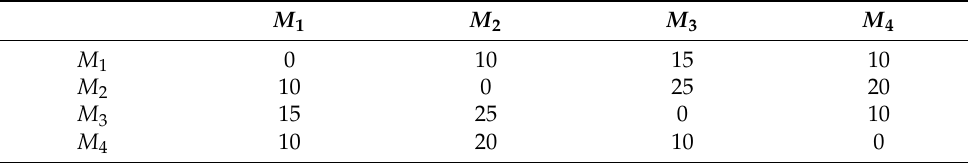
Figure 1. The process of processing the product A for the finished product. Table 1. The transportation time required for movement of the operation between different The objective function